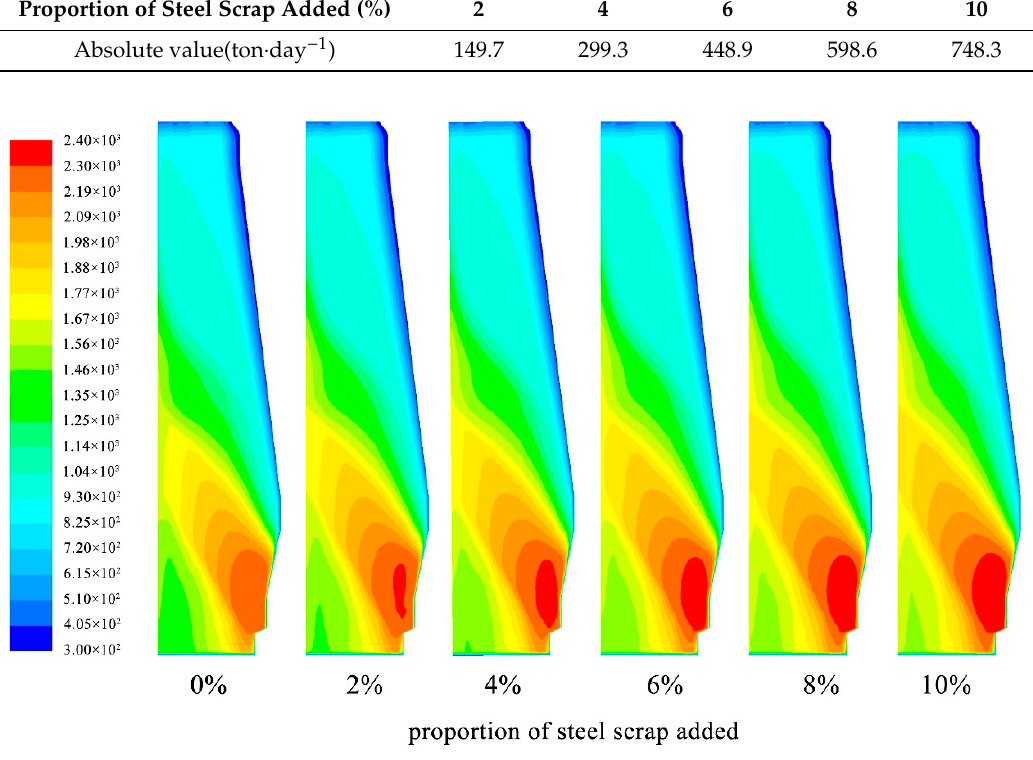
Figure 8. Temperature profiles at di ff erent proportions of steel scrap